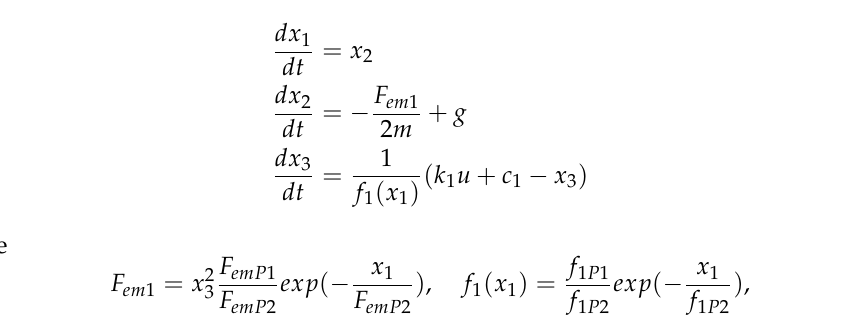
state variables are: x 1 = x —position of the ball, x 2 —velocity of the ball, x 3 = I —current in